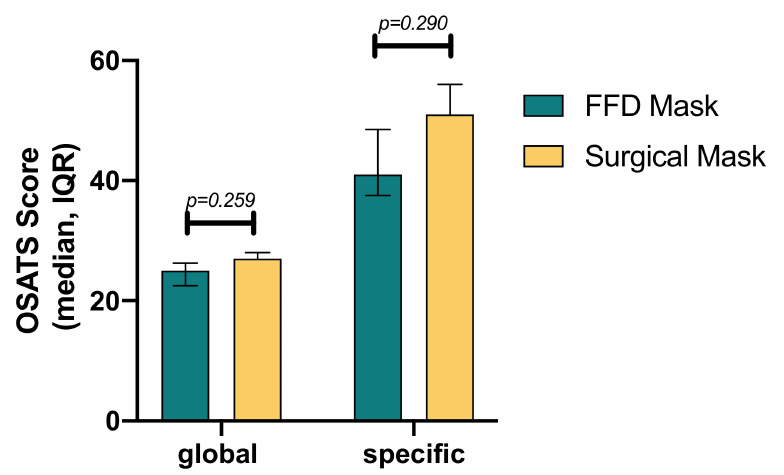
Figure 4. Global and procedure-specific Objective Structured Assessment of Technical Skills (OSATS) score results for laparoscopic cholecystectomy. The median of the OSATS scores and p -values are shown. IQR, interquartile